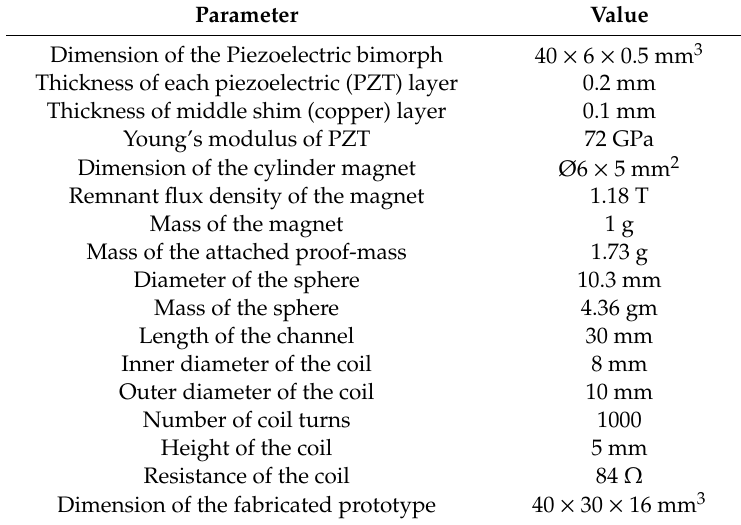
Figure 4. Photographs of the prototype components ( a ), fabricated prototype ( b ), schematics of the parallel bimorph connection ( c ), and the magnet-coil assembly ( d ). Table 1. Geometric parameters and materials properties of the harvester components.